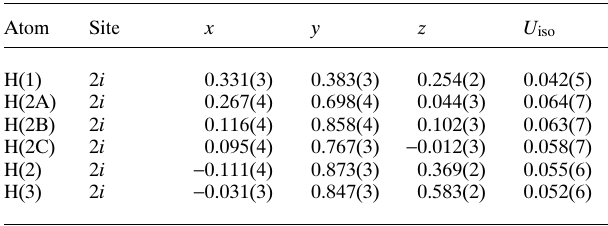
Table 2. Atomic coordinates and displacement parameters (in Å 2 )